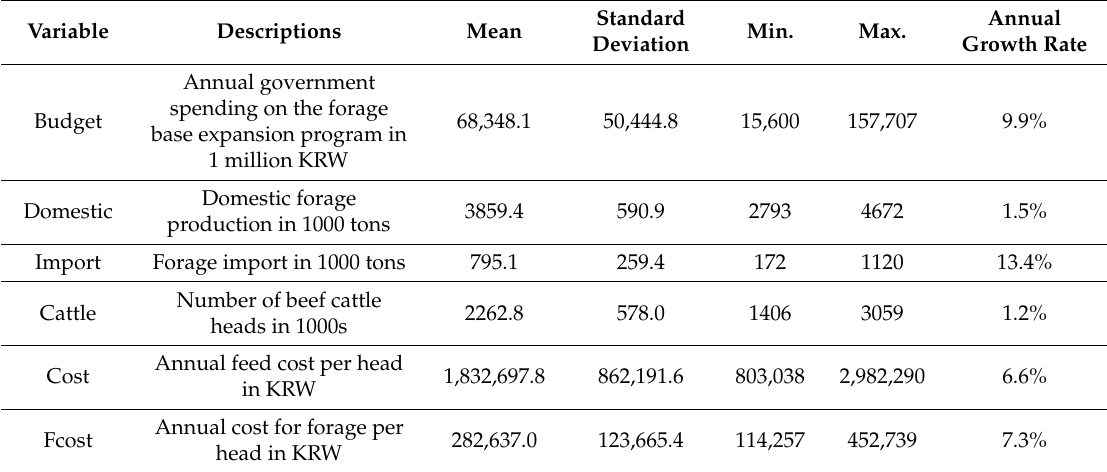
Table 1. Descriptive statistics for forage and beef cattle industry in Korea: 1998–2016.